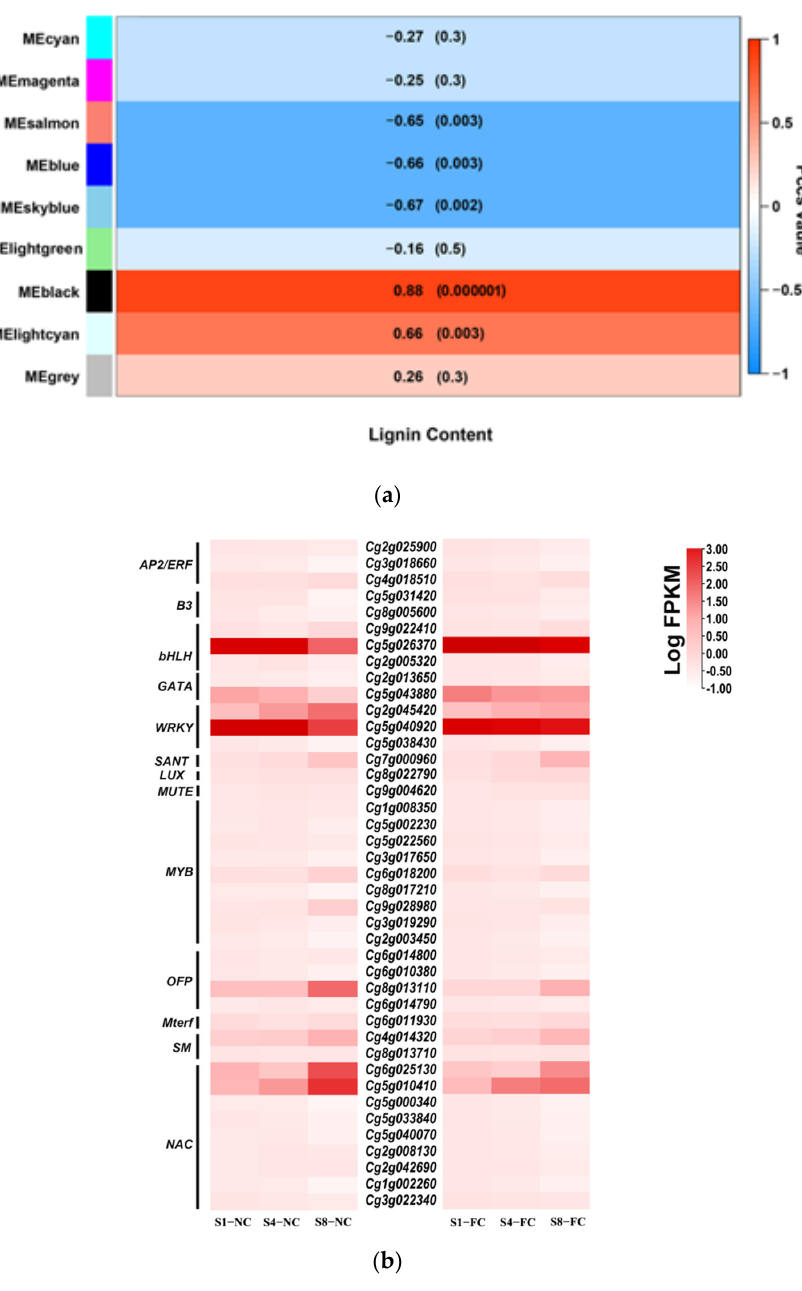
Figure 6. Weighted Gene Co-Expression Network Analysis (WGCNA) analysis of DEGs. ( a ) The module-sample correlations between DEGs and lignin content. Corresponding p values of module- sample correlations are indicated in parentheses. The panel on the left side shows the nine modules: cyan module (MEcyan), magenta module (MEmagenta), salmon module (MEsalmon), blue module (MEblue), skyblue module (MEskyblue), lightgreen module (MElightgreen), black module (MEblack), lightcyan module (MElightcyan), grey module (MEgrey). The colour scale on the right side shows module-trait correlations from − 1 (blue) to 1 (red). ( b ) Heatmap of TFs in NC and FC juice sacs at three